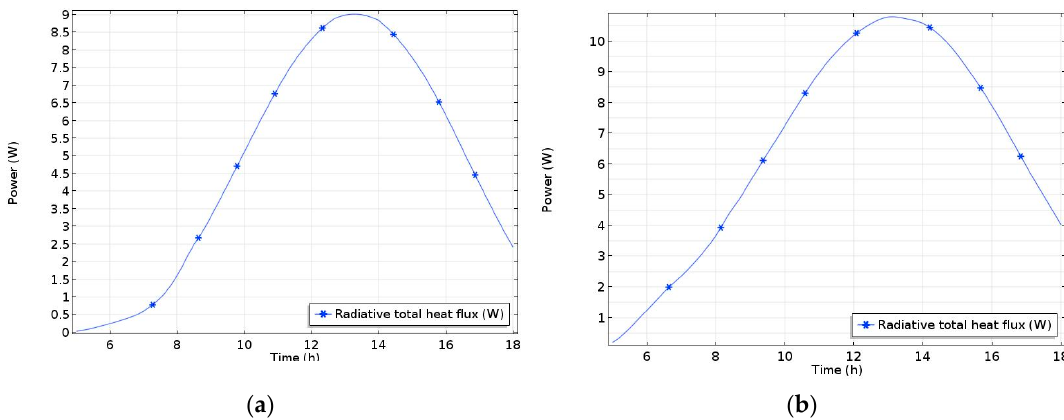
Figure 14. Radiative total heat flux through the solar cell n.2: ( a ) covered CPC system (17 July 2017); ( b ) uncovered CPC system (18 July 2017). Energies 2020 , 13 , x FOR PEER REVIEW